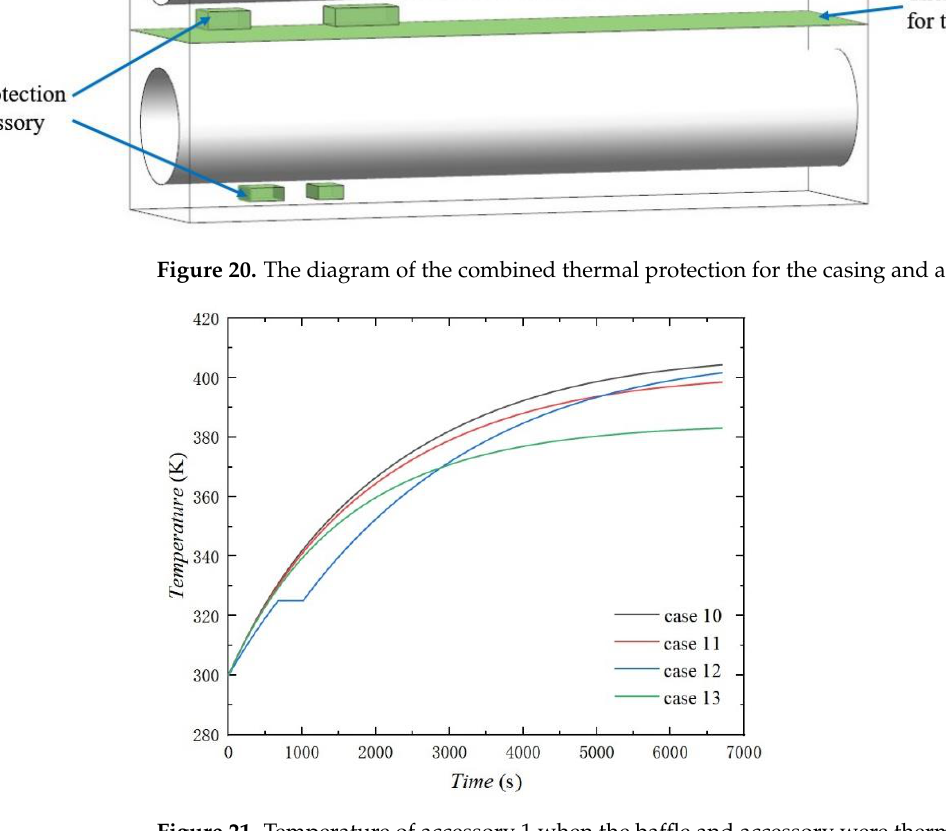
Figure 21. Temperature of accessory 1 when the baffle and accessory were thermally protected.